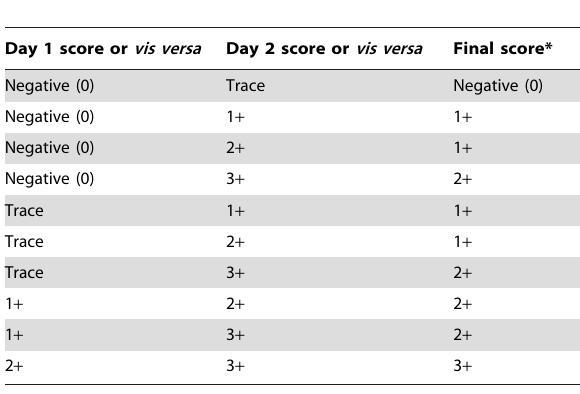
Table 1. Scoring scheme to obtain final urine POC-CCA cassette test